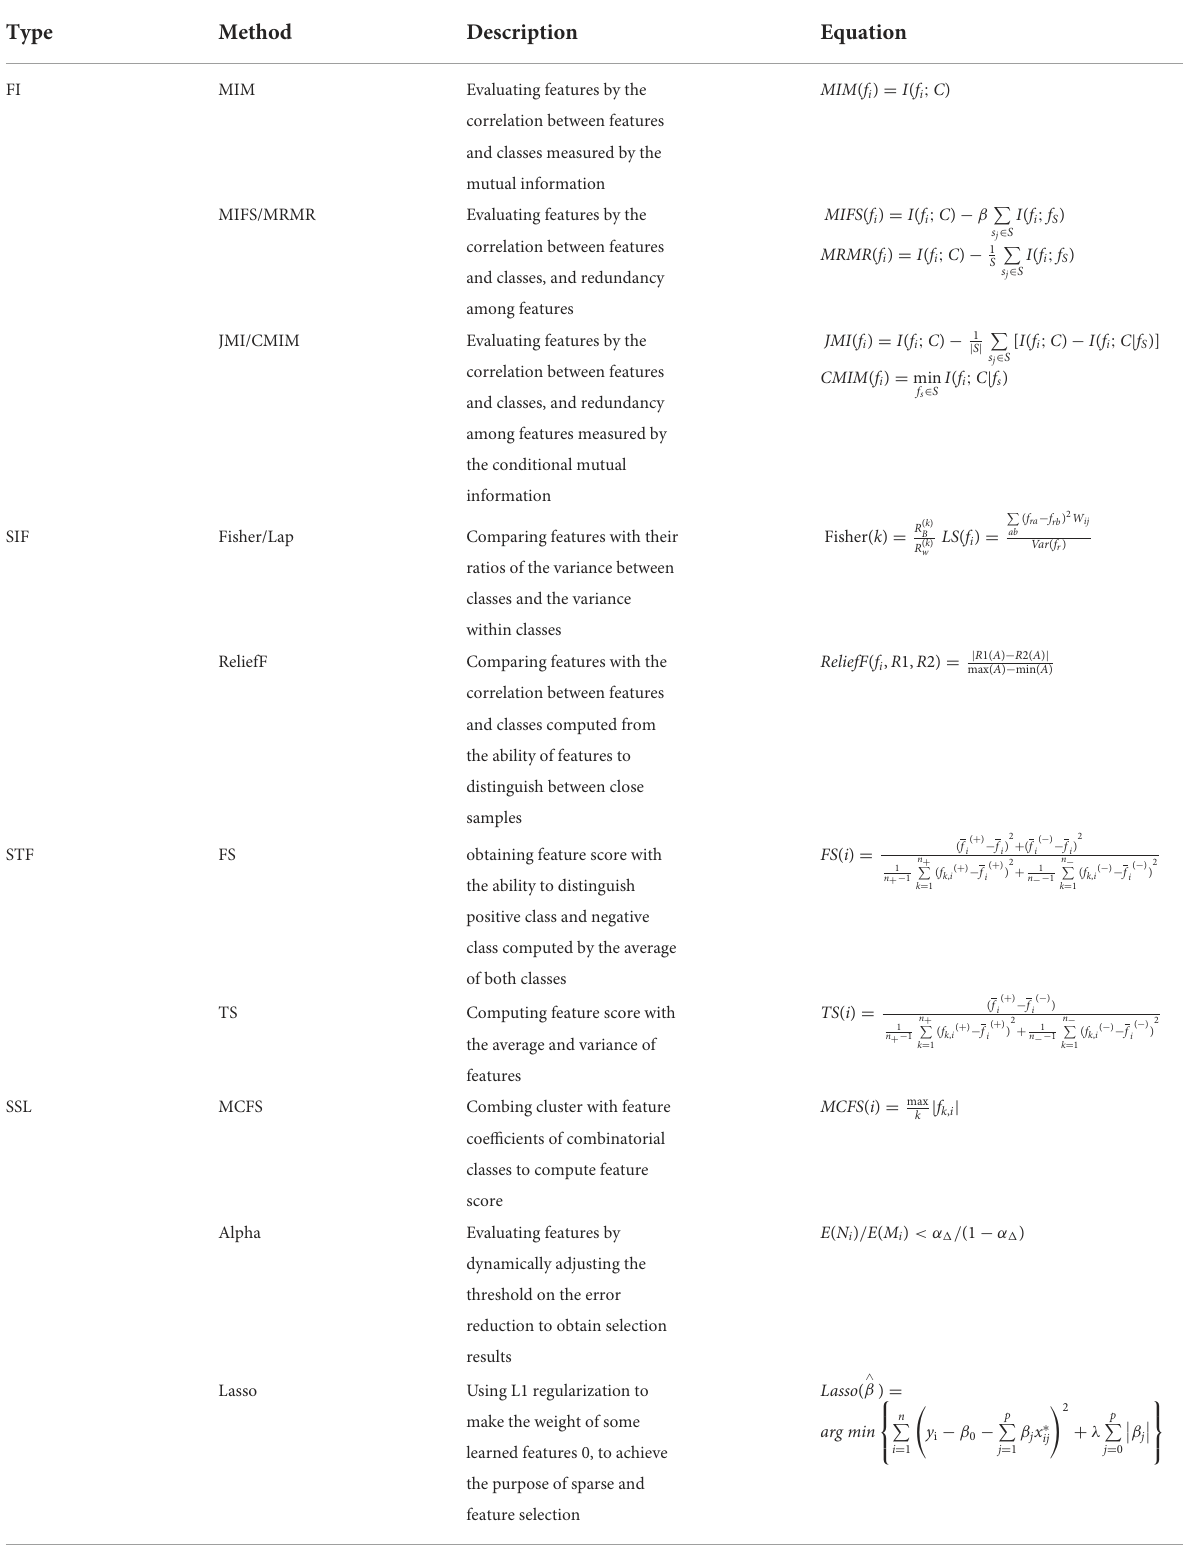
TABLE 2 Descriptions of the 13 feature selection methods used in this